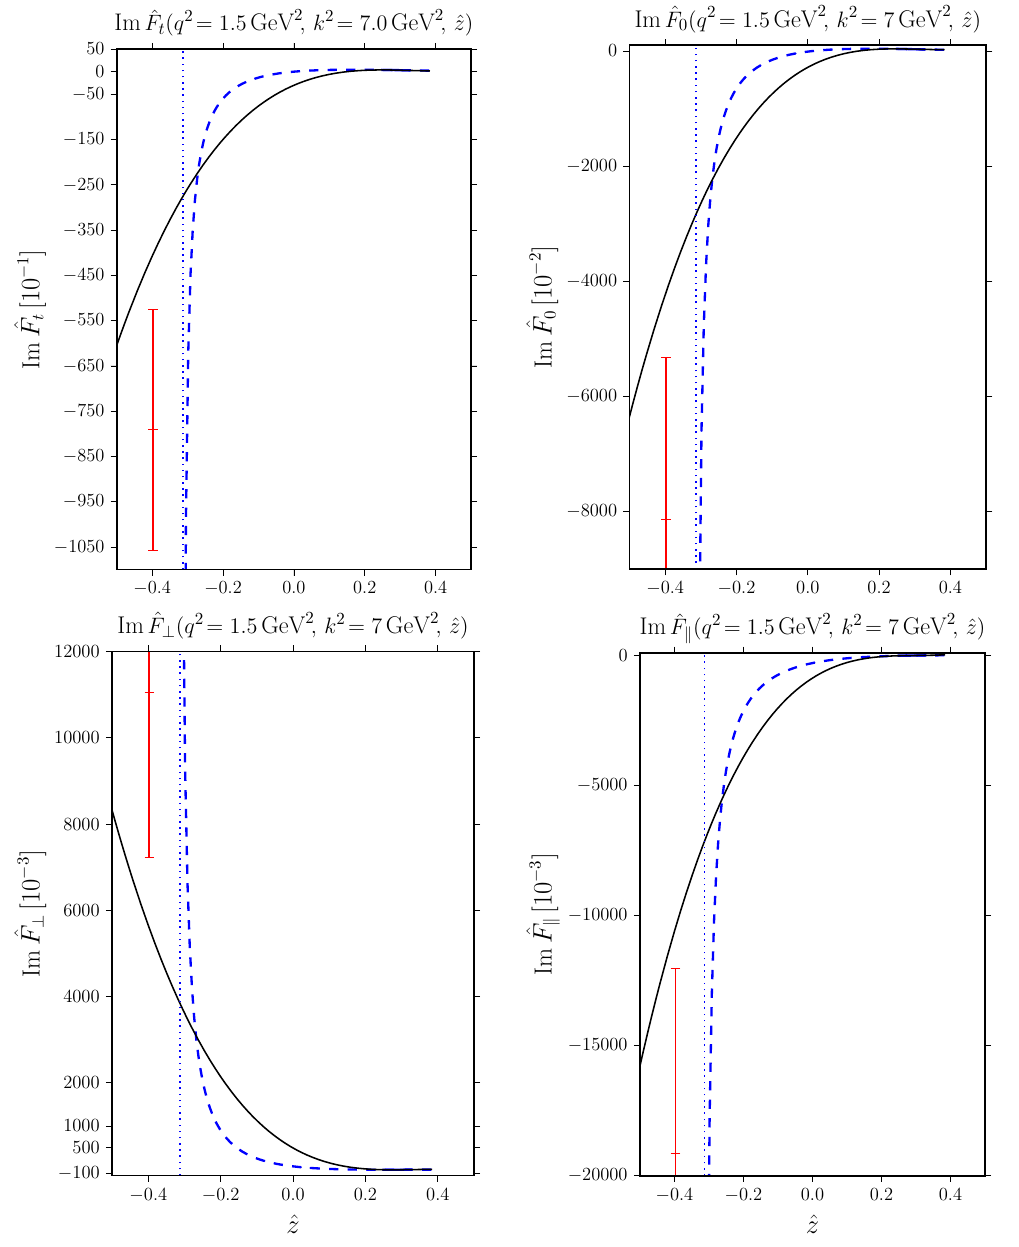
Figure 1 . Plots of the ^ z dependence of the form factors in the phase space point ( q 2 = 1 : 5 GeV 2 ; k 2 = 7 GeV 2 ). Here ^ F (cid:21) F (cid:21) = ^ P B (cid:3) in order to be able to visualize the agreement be- (cid:17) tween the parametrization and the residues on the B (cid:3) pole. The dashed lines show the QCDF predictions at LO in (cid:11) s , including both the twist-2 and twist-3 contributions. These predicitions are valid in the region where 0 : 25 ^ z 0 : 33. Beyond this region, QCDF breaks down and (cid:20) (cid:20) the curve shown should be understood as merely an extrapolation. Our (cid:12)t result, based on the parametrization in eqs. (2.11){(2.13), is shown as the black solid line. The residues following from section 2.2 are shown as red data points. The dotted vertical lines highlight ^ z ( ^ q 2 = M 2 ), to show B the unphysical pole emerging from the QCDF results at ^ q 2 M 2 . With these plots we deliberately B ’ show the phase-space points that correspond to the largest tensions ( < 2 (cid:27) ) between the B (cid:3) residues and our (cid:12)t.